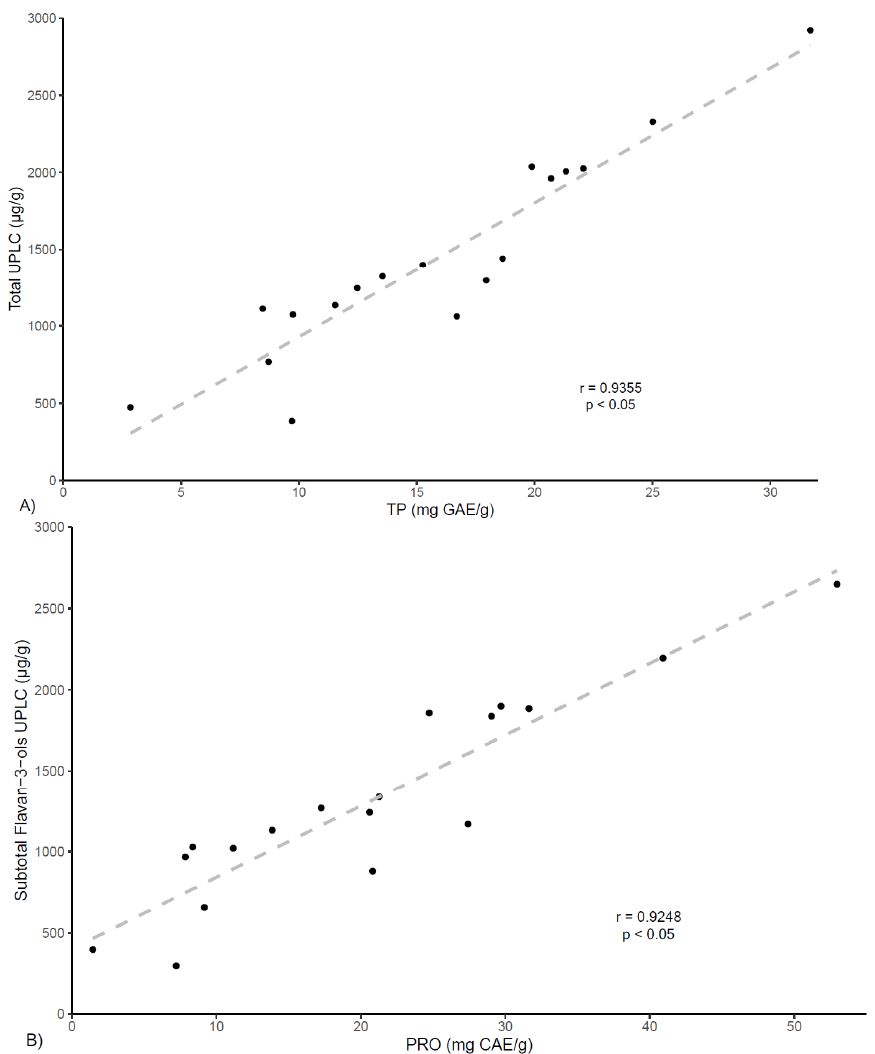
Figure 3. Correlation of ( A ) TP and UPLC total polyphenolic contents and ( B ) PRO and UPLC Flavan-3-ols contents.